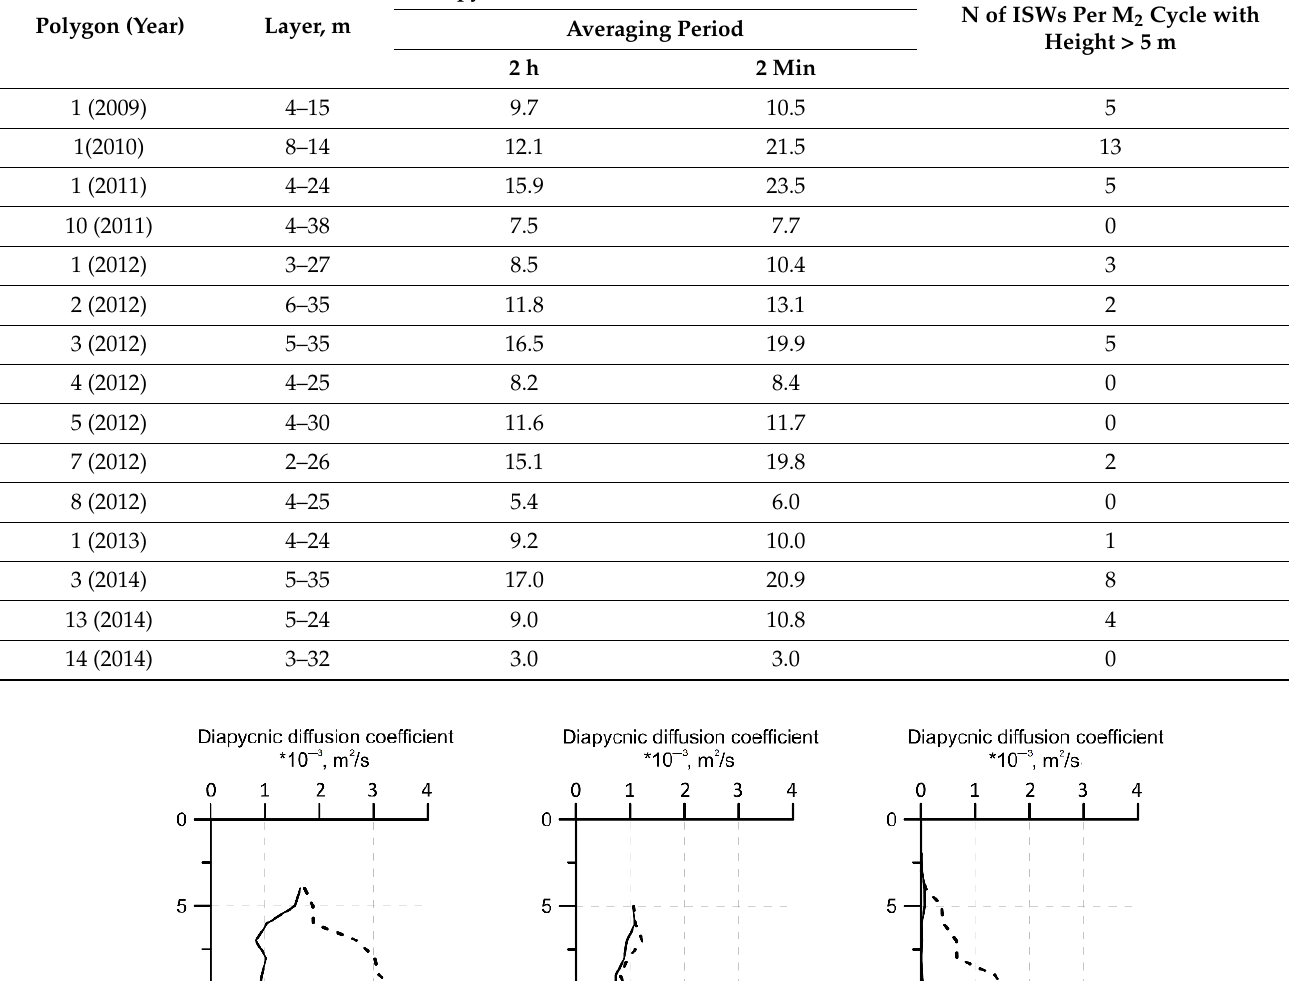
Table 3. Averaged K z estimates at different polygons supplemented with statistics of ISW observations